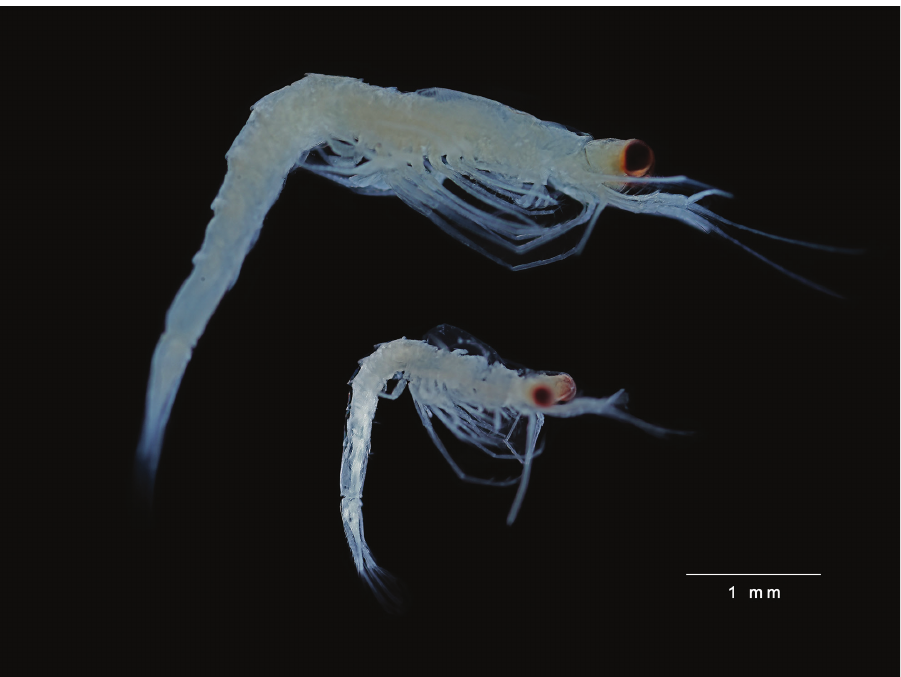
Figure 2. Rhopalophthalmus longipes Ii, 1964, A immature female, 6.5 mm, UKMMZ-1553 B juvenile, 2.4 mm, UKMMZ-1554, Pulau Tinggi,